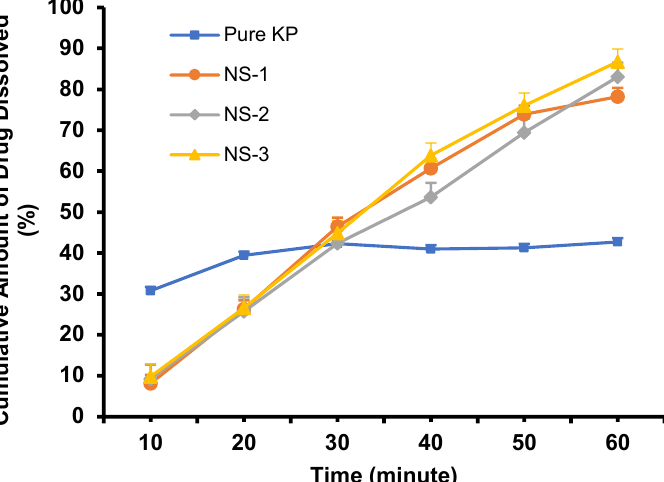
Figure 8. Dissolution profile curve of ketoprofen nanosuspension (n = 3, mean ± SD, p > 0.05).